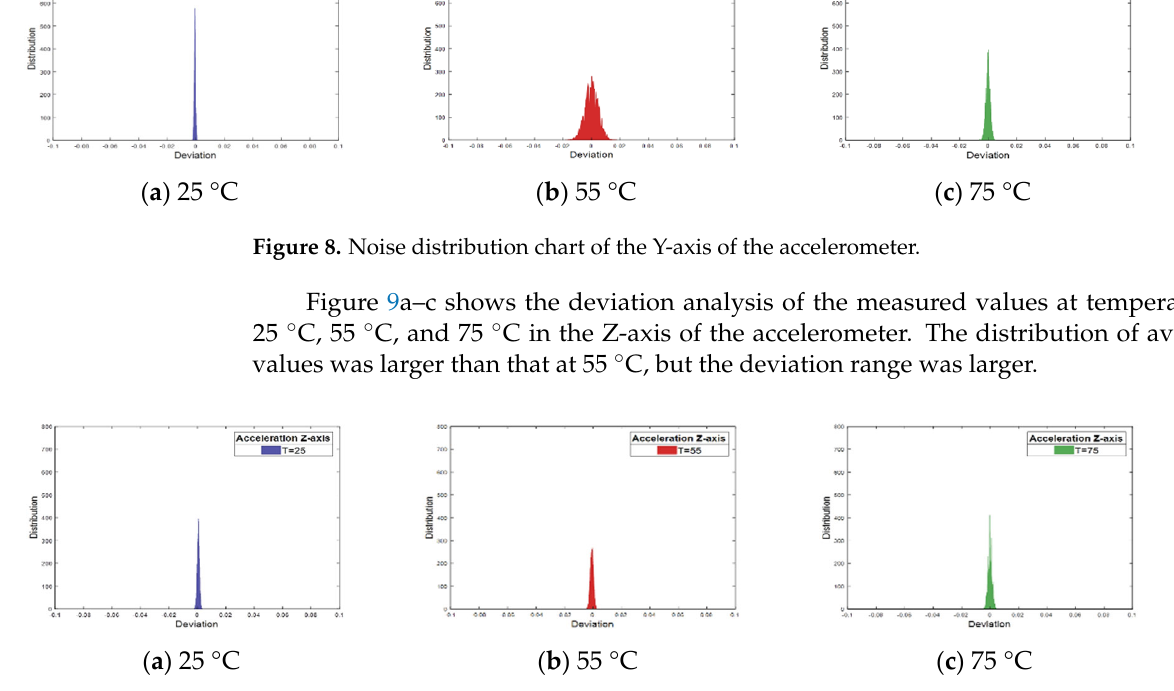
Figure 7. Noise distribution charts of the X ‐ axis of the accelerometer.